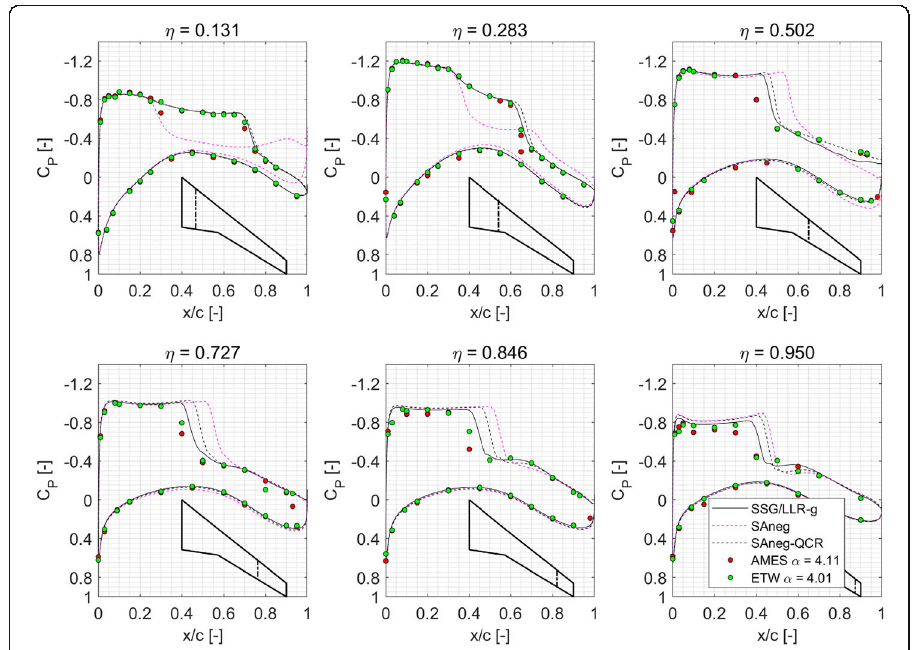
Fig. 3 Comparison with experiment of C P at 6 spanwise locations predicted at M = 0.85, Re = 5 million and α = 4.0